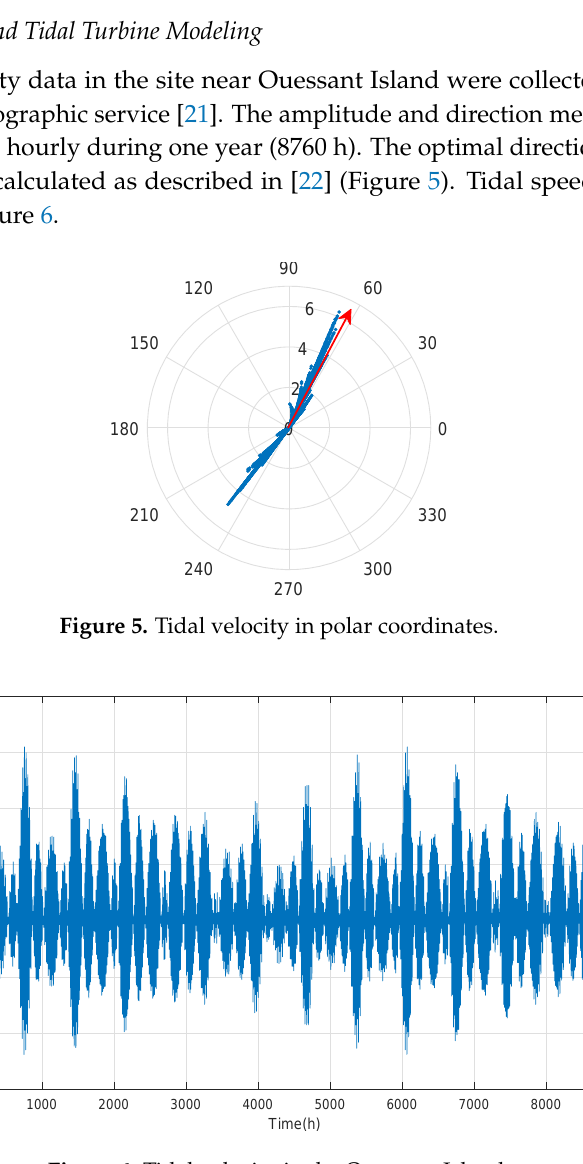
Figure 6. Tidal velocity in the Ouessant